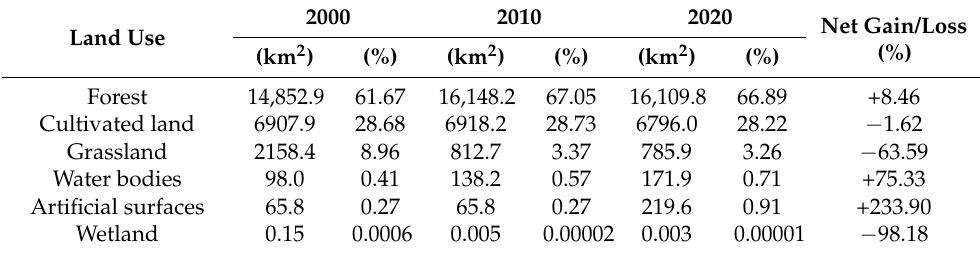
Figure 2. Land-use patterns and changes in Enshi Prefecture from 2000 to 2020. ( a ) Land-use patterns in 2000; ( b ) Land-use patterns in 2010; ( c ) Land-use patterns in 2020. Table 2. Land-use structures in Enshi Prefecture from 2000 to